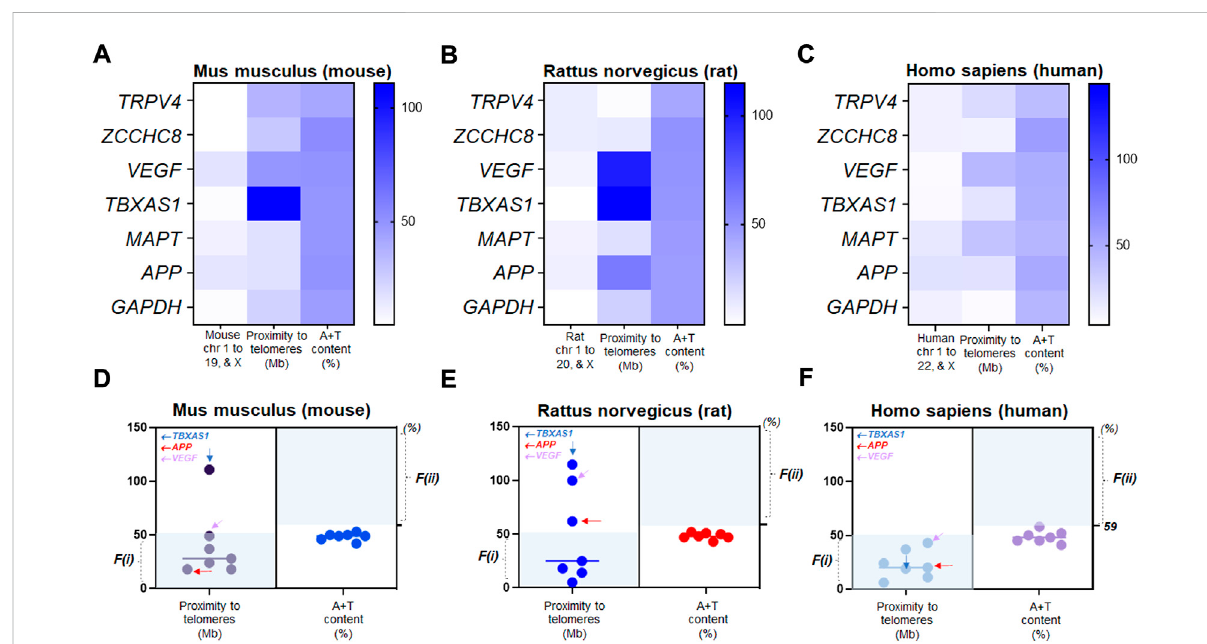
Relative mutability in human genes driven by proximity to telomeres (A) The color-coded map showing chromosomal location, distance to a telomere, and A+T content of Mus musculus (mouse) TRPV4 and other genes in chromosome numbers (chr 1 to 19 and X), proximity to telomeres (Mb), and A+T content (%). (B) the color-coded map showing chromosomal location, distance to a telomere, and A+T content of Rattus norvegicus (rat)TRPV4andothergenesinchromosomenumbers(chr1to20andX),proximitytotelomeres(Mb),andA+Tcontent(%). (C) thecolor-coded map showing chromosomal location, distance to a telomere, and A+T content of Homo sapiens (human) TRPV4 and other genes in chromosome numbers(chr1to22andX),proximitytotelomeres(Mb),andA+Tcontent(%). (D) Scatterplotsdisplayingrelativemutabilityofsevenmousegenesby proximity totelomeres(left)andA+T content (right). Shadedregionswith lightcolors (blue)indicategenessatisfying eitherofthetwofactors.Genes outsidetheshadedregions atn=2byF(i);n=7byF(ii))arerelativelylessmutable. (E) Scatterplots displayingrelativemutabilityofsevenratgenesby proximity totelomeres(left)andA+T content (right). Shadedregionswith lightcolors (blue)indicategenessatisfying eitherofthetwofactors.Genes outside the shaded regions at n = 3 by F(i); n = 7 by F(ii)) are relatively less mutable. (F) Scatter plots displaying relative mutability of the same